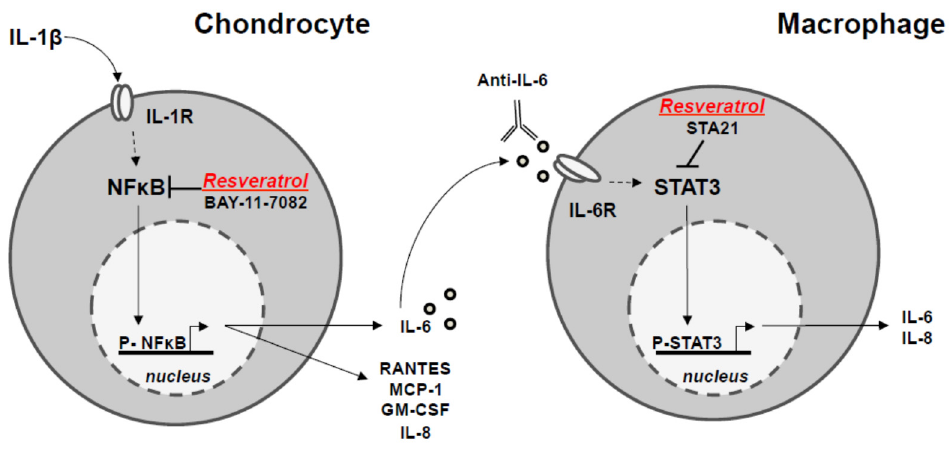
Figure 6. Proposed mechanism of anti-inflammatory properties of resveratrol revealed in the cross-talk between chondrocyte and macrophage in the chondrocyte/macrophage coculture model.